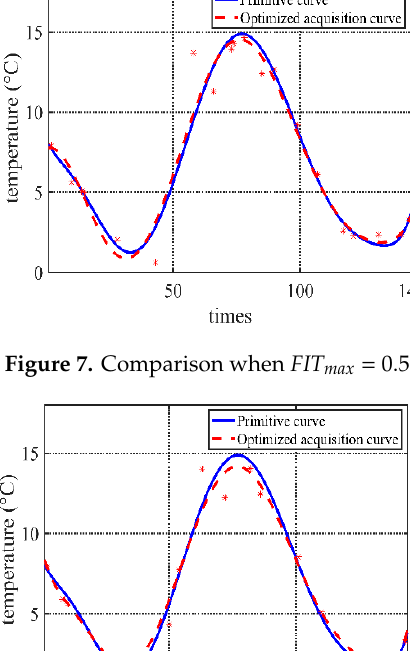
Figure 6. The Pearson correlation coefficient of several days.